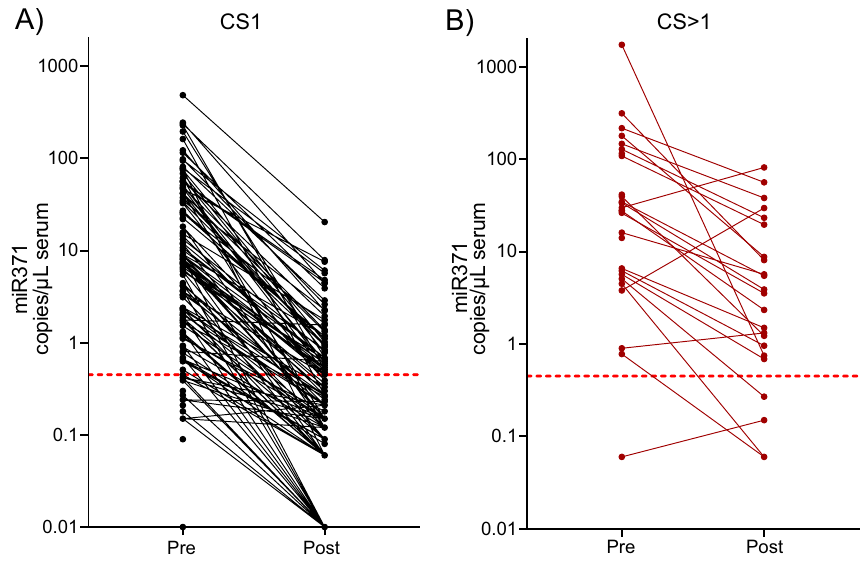
Figure 3. miR371 levels pre- and post-orchiectomy. The decrease in miR371 after orchiectomy in CS1 (N = 131, ( A )) and for CS > 1 (N = 28, ( B )). The red, dotted line marks the threshold for calling miR371 as